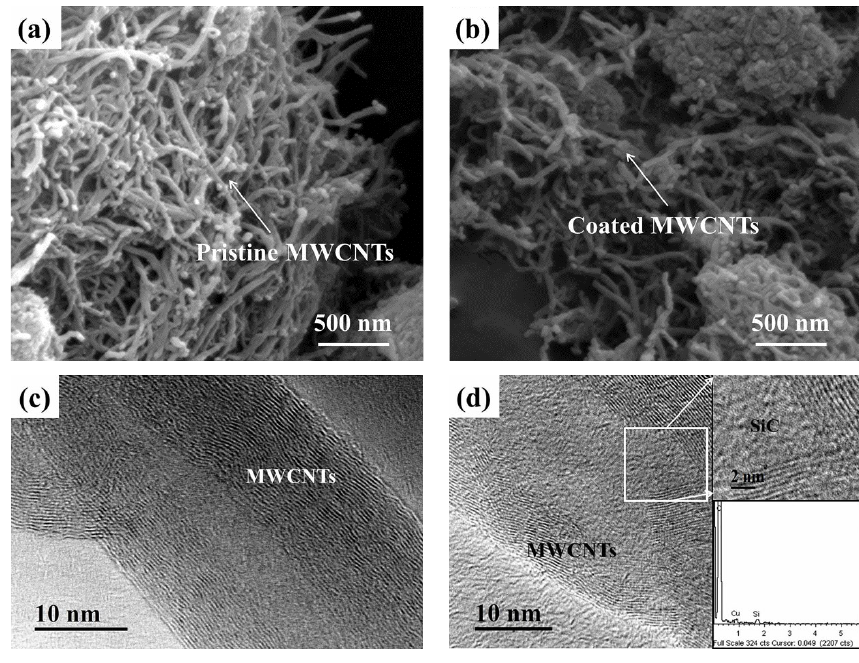
Fig. 2 SEM and TEM pictures of MWCNTS without (a, c) and with (b, d) SiC coating.